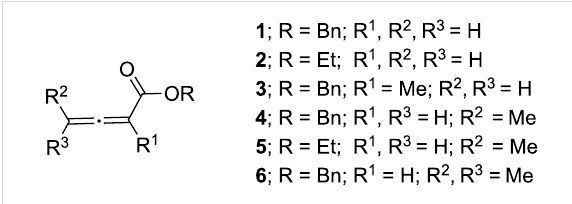
Figure 1: Allene esters synthesized for this study.